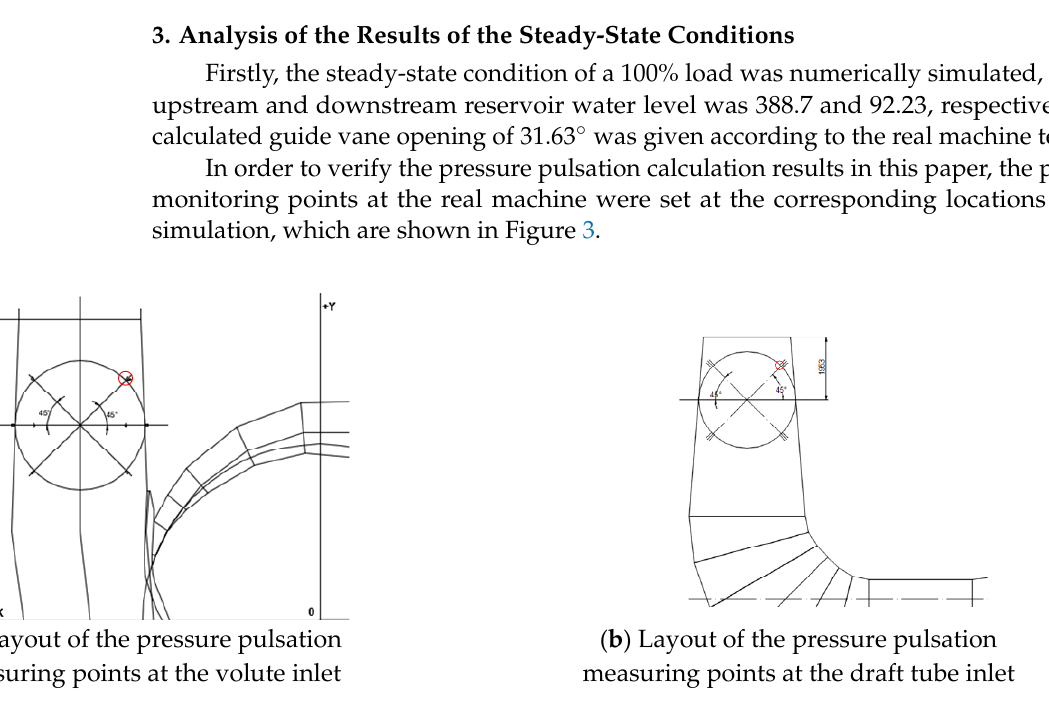
Figure 3. Diagram of the pressure pulsation measuring point location. Table 3. Comparison of the mean values under pressure.